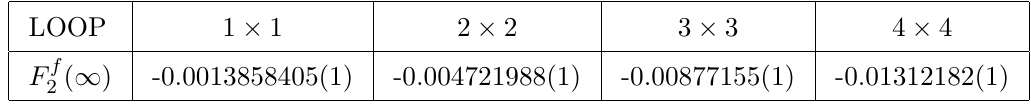
Table 4. Values at in(cid:12)nite volume of the function F f Wilson fermions.